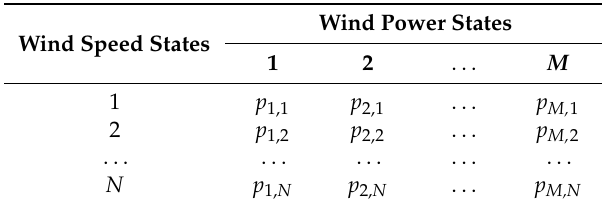
Table 1. Joint distribution of wind speed states and wind power states.